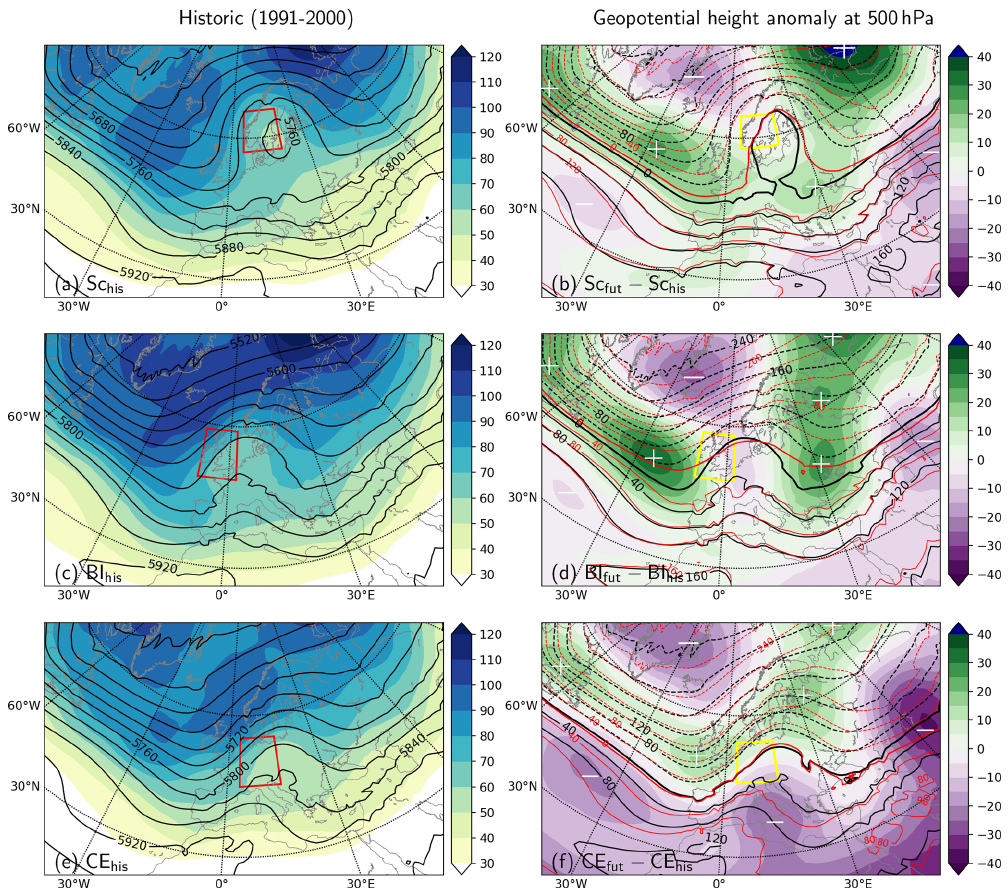
Figure 4. Composites of the geopotential height fields at 500hPa for the first day of heatwaves in different European regions: (a, b) Scan- dinavia (Sc), (c, d) British Isles (BI) and (e, f) Central Europe (CE). Panels (a) , (c) and (e) refer to the historic time slice (1991–2000) with mean geopotential height (black contours, in geopotential meters, or gpm) and standard deviation (shaded, in gpm). Panels (b) , (d) and (f) show the difference between the historic and future (2091–2100) mean geopotential anomaly fields at 500hPa. For the calculation of these anomalies, the mean geopotential height for the first day of all heatwaves inside the respective area is first subtracted from the geopotential height composites. The resulting fields are shown by black (historic) and red (future) contours in the right column. The color shading then shows the difference between the two fields (future minus historic); violet (green) shading indicates areas of lower (higher) geopotential height in the future. Relative minima (maxima) of the difference fields (rough estimates) on the right column are labeled by minus (plus)